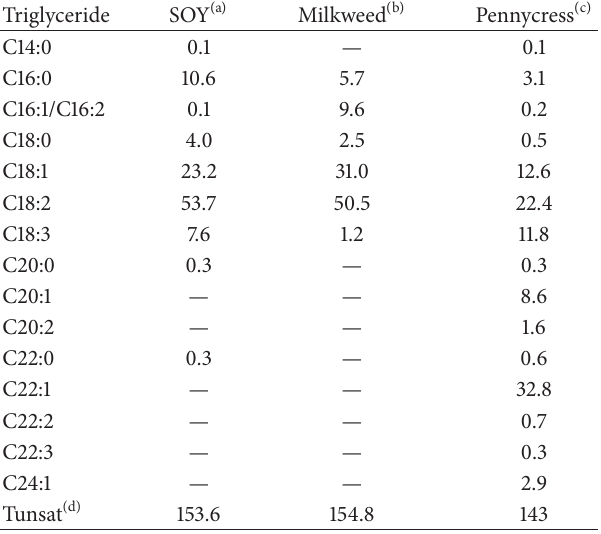
Table 2: Fatty acid composition of vegetable oils (%